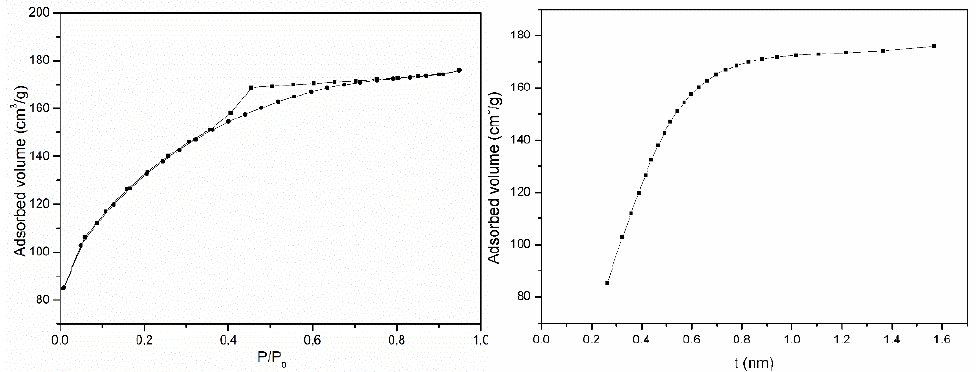
Figure 4. N 2 adsorption-desorption isotherm ( left ) and t -plot ( right ) for sample SCA.